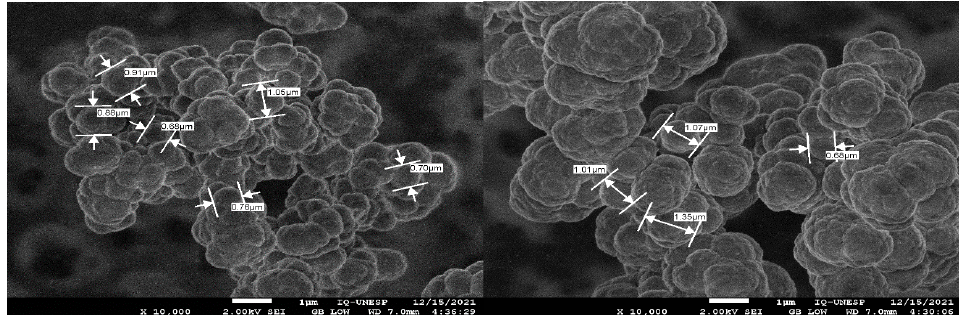
Figure 1. SEM micrographs of ( left side ) IIP–MeHg and ( right side ) NIP (magnification: 10,000×).